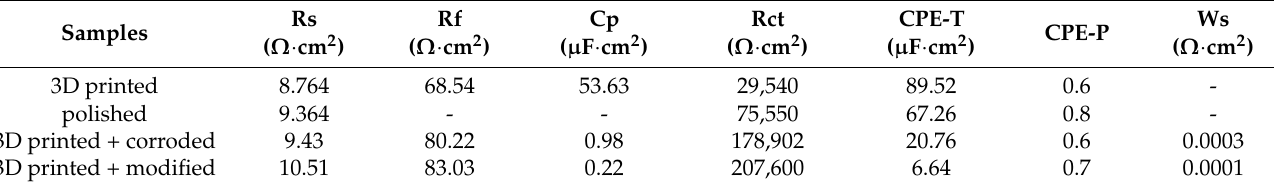
Table 2. Parameters of equivalent circuit components of different samples.